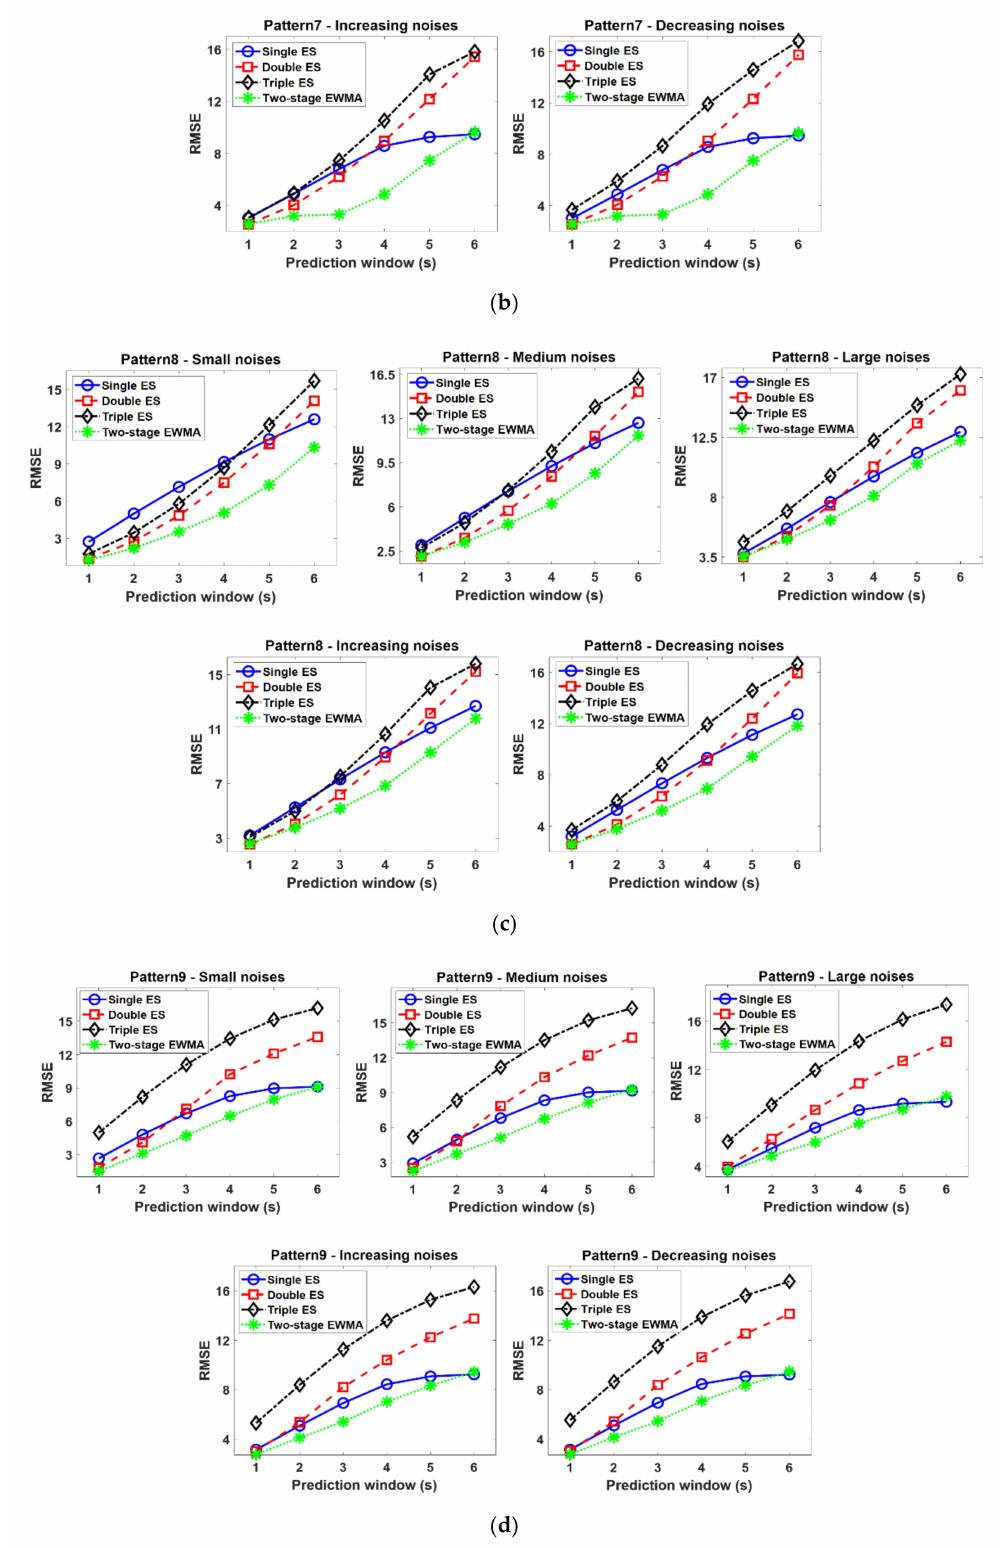
Figure 5. Comparison results between the single ES, double ES, triple ES, and two-stage EWMA in ( a ) Pattern 6, ( b ) Pattern 7, ( c ) Pattern 8 and ( d ) Pattern